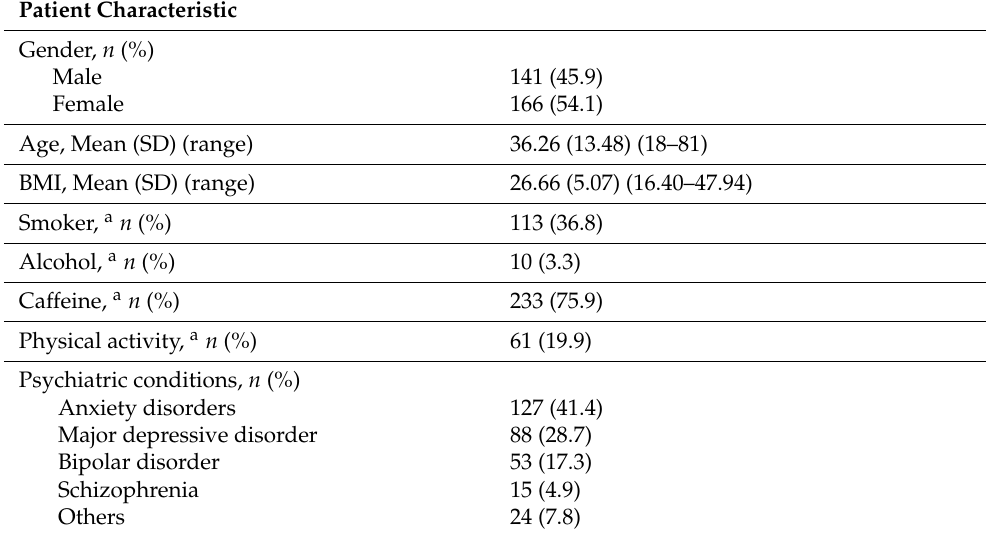
Table 1. General Characteristics of the Study Participants ( n =